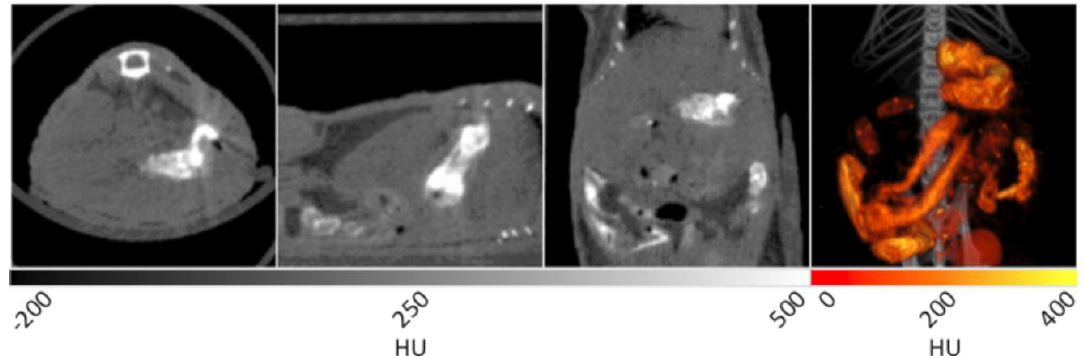
Figure 7. X-ray CT data of a murine gastrointestinal tract with barium sulfate contrast enhancement. After performing a best quality CT scan, the data was reconstructed with Albira software and analyzed via PMOD. In the first panel, the stomach can be seen and in the second and third panels, loops of the small intestine can be seen. The 3D reconstruction is false colored to aid in the visualization of the GI